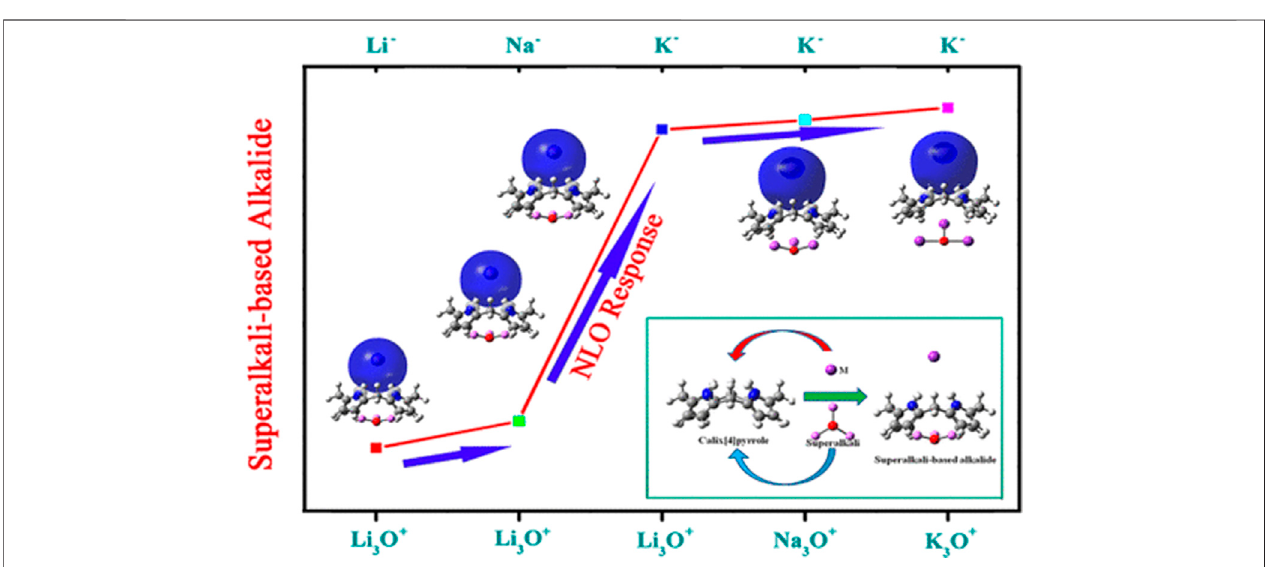
FIGURE5 | Superalkali based alkalides ofLi 3 O + (calix[4]pyrrole)M − and M 3 O + (calix [4]pyrrole)K − complexes. Reprinted from W.M. Sun et al.,2014withpermission from Copyright (2014) American Chemical Society.